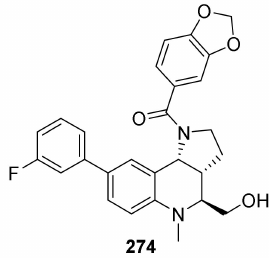
Figure 6. Inhibitor of the aminostransferase BioA.